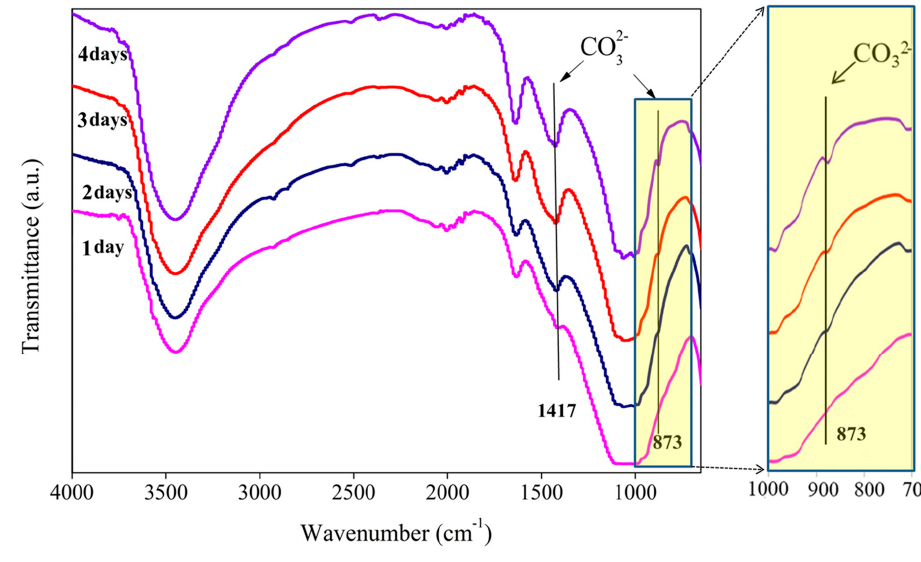
Figure 6. FTIR traces of TTCP soaked in SBF for one, two, three, and four days.